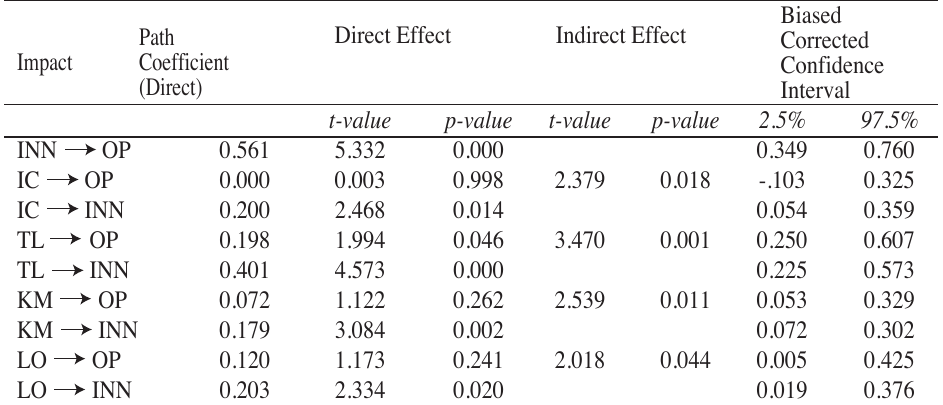
Table 4. Composite Reliability and Cronbach's